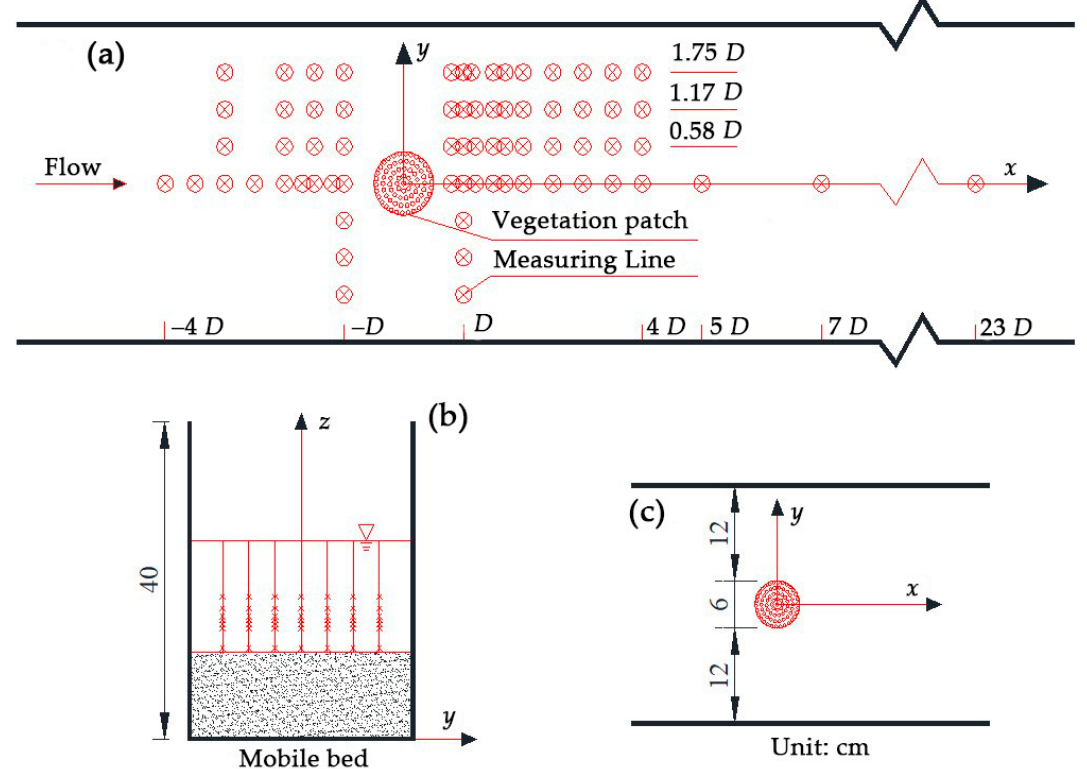
Figure 1. The schematic pattern of the vegetation community arrangement. The patch model is arranged in the center of the flume. ( a ) Vertical view (Detail drawing) ( b ) Front view ( c ) Vertical view.